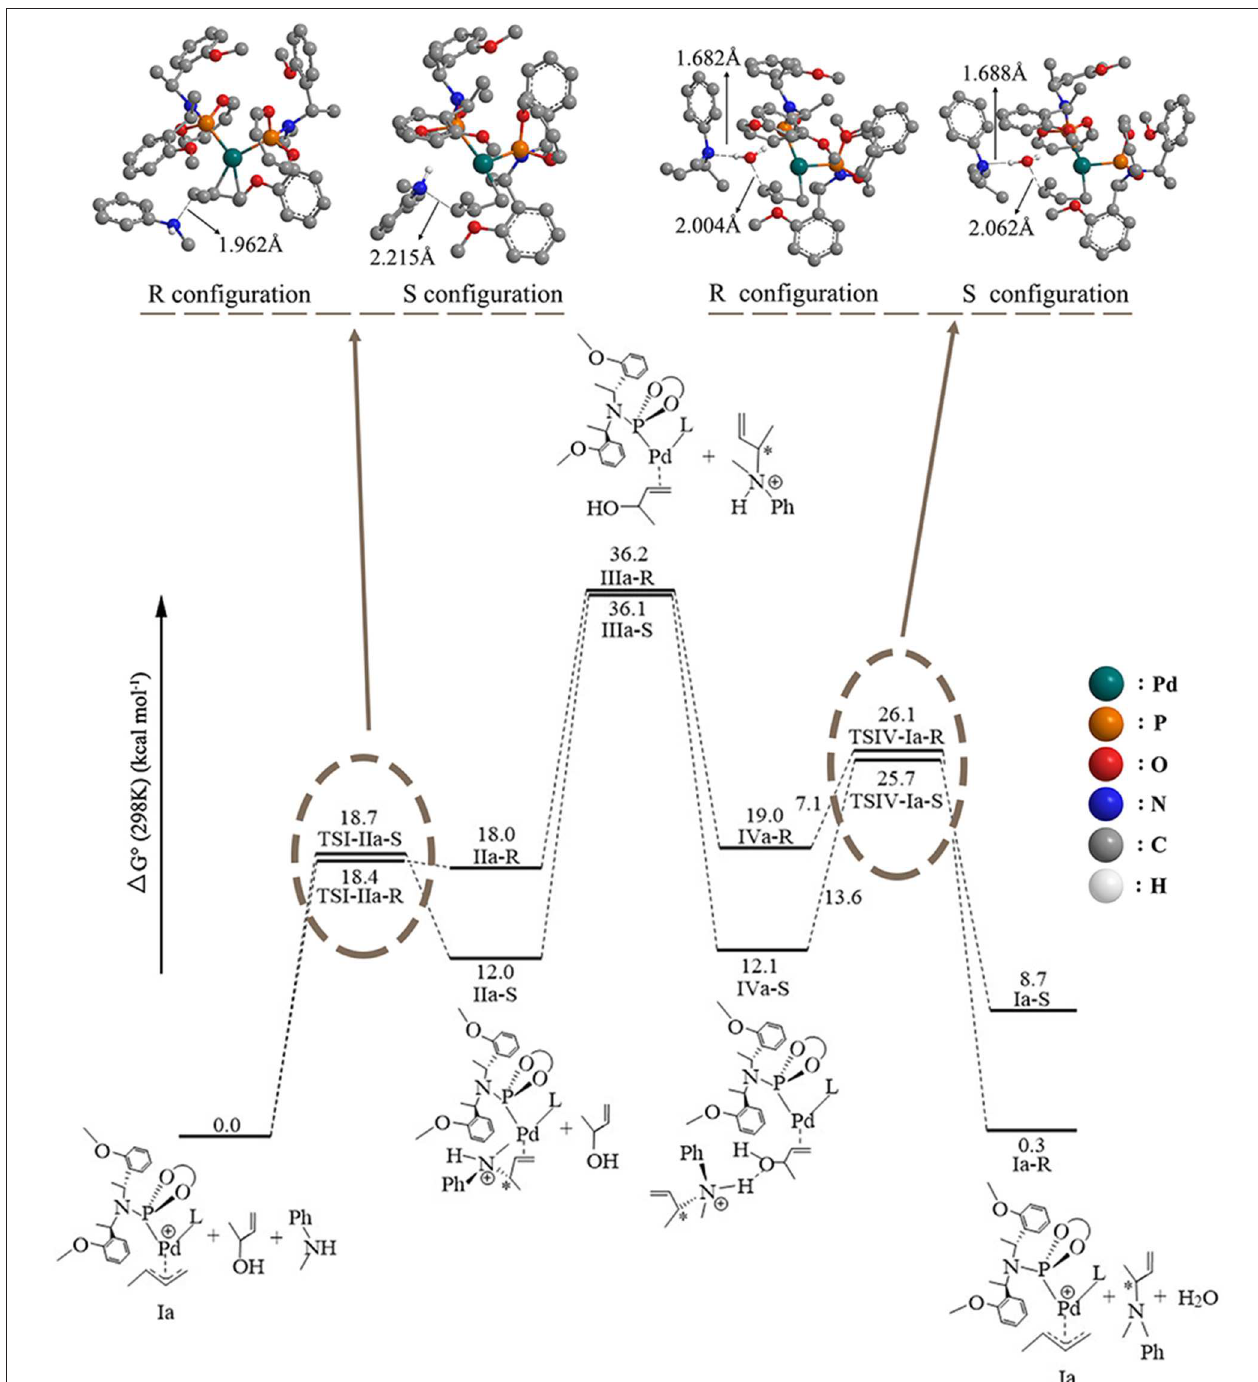
FIGURE 2 | The overall free energetic profiles for the 3-butene-2-ol amination reaction process in gas catalyzed by phosphoramidite palladium.